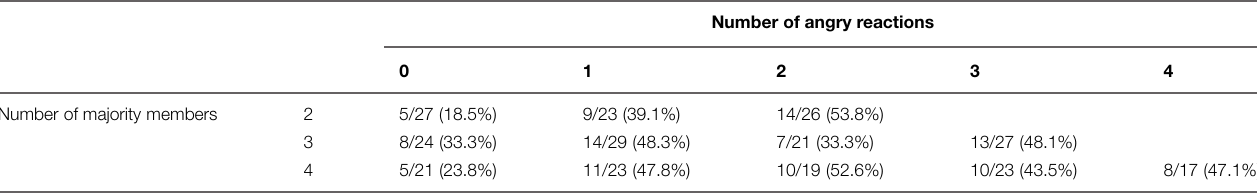
TABLE 1 | Number of participants conforming and total number of participants in each condition (Study 1).